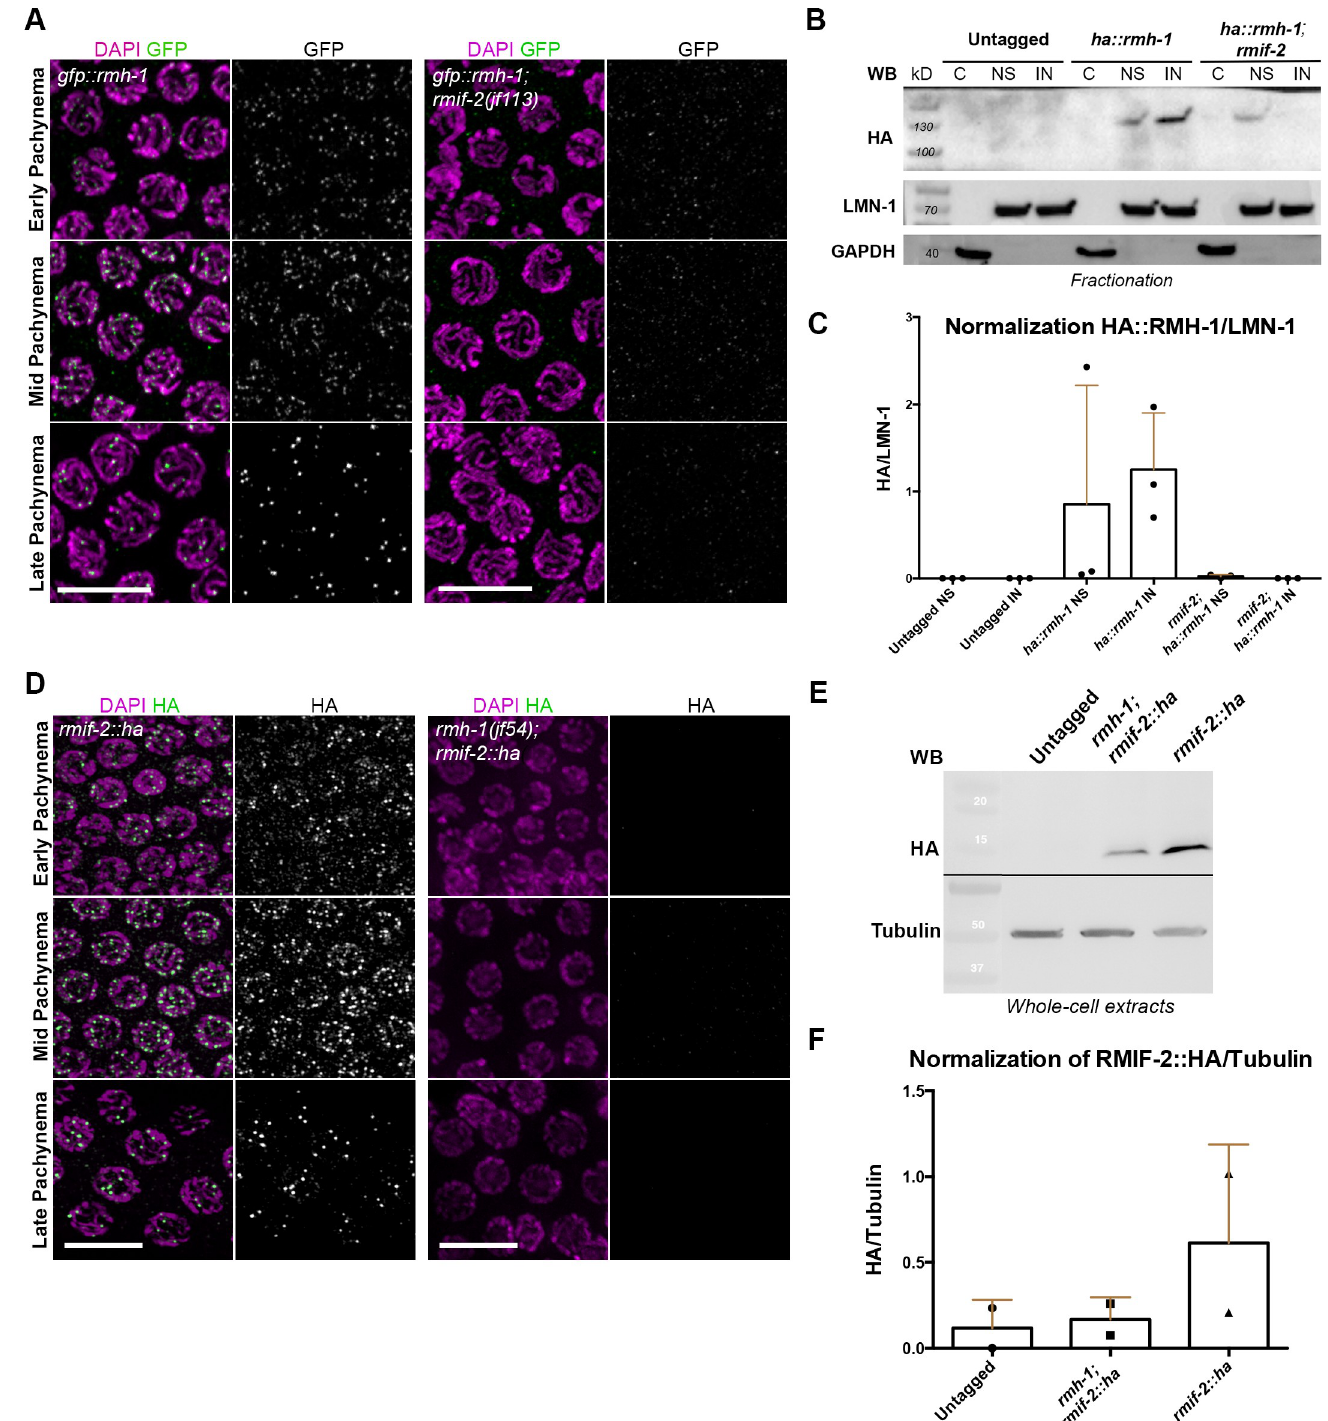
Fig 3. Chromatin loading and abundance of RMIF-2 and RMH-1 proteins are mutually dependent. (A) Representative images of gfp :: rmh-1 and gfp :: rmh-1; rmif-2(jf113) pachytene nuclei stained with DAPI (magenta) and GFP (green). GFP::RMH-1 localization to nuclear foci starts in early pachynema, peaks in mid pachynema, and becomes concentrated in six foci in late pachynema. In the rmif-2 mutant background, RMH-1 fails to localize into foci throughout pachynema, except for a very few cytoplasmic foci. Scale bar: 10 μ m. (B) A protein fractionation shows specific HA::RMH-1 enrichment in the nucleus, which is reduced in the rmif-2 mutant. Equal amounts of protein were loaded for each fraction. C = cytosolic fraction, NS = soluble nuclear fraction, IN = insoluble nuclear fraction. LMN-1 was the loading control for nuclear fractions; GAPDH was the loading control for the cytosolic fraction. (C) Western blot normalization and quantification of